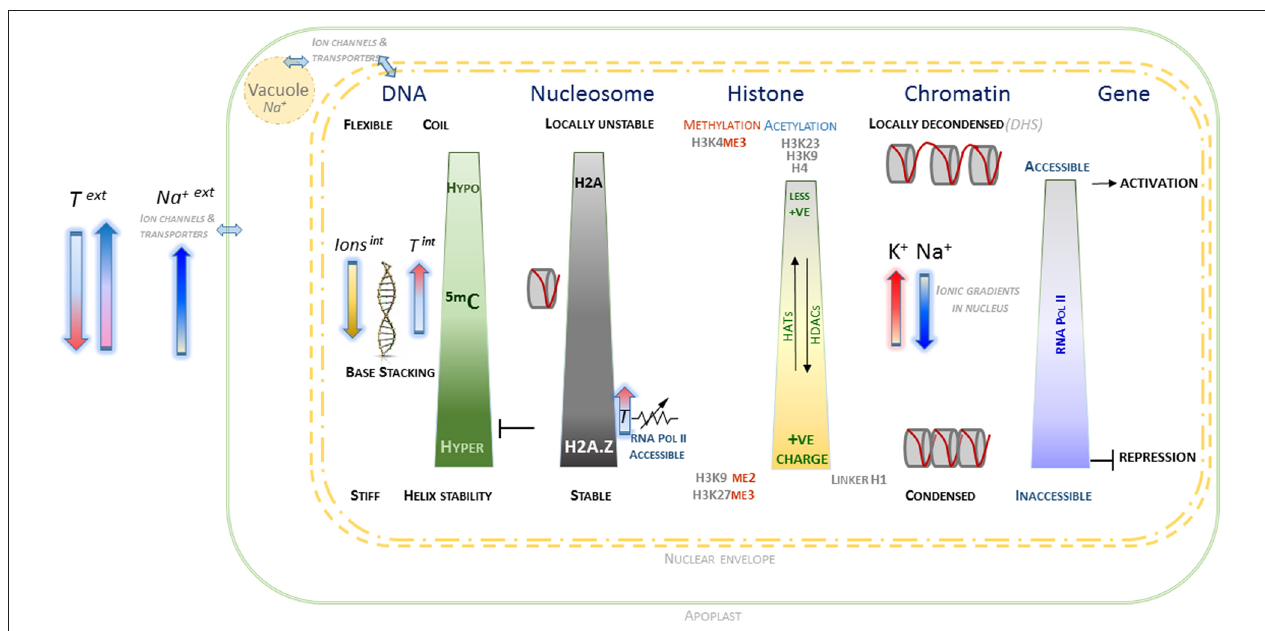
FIGURE 1 | Schematic overview of interactions associated with chromatin and component macromolecules within the electrostatic environment of the plant nucleus. The contrasting states of DNA, histones, nucleosomes and chromatin as affected by epigenetic marks and localized nuclear ionic environment are indicated. The arrows indicating external temperature and salt are oriented in relation to their observed effects on DNA methylation and H2A status. Internal cation concentrations contribute to level of chromatin condensation, along with more complex electrostatic interactions, including those involving histone modifications and divalent cations. The contribution of histone acetylases (HAT) and deacetylases (HDAC) to H4 and H3 acetylation are indicated, which along with the interplay with histone methylation is able to provide a complex chromatin code. The nuclear envelope is represented by dashed double yellow lines, with a very simplified representation of interactions between the cytoplasm, vacuole and external